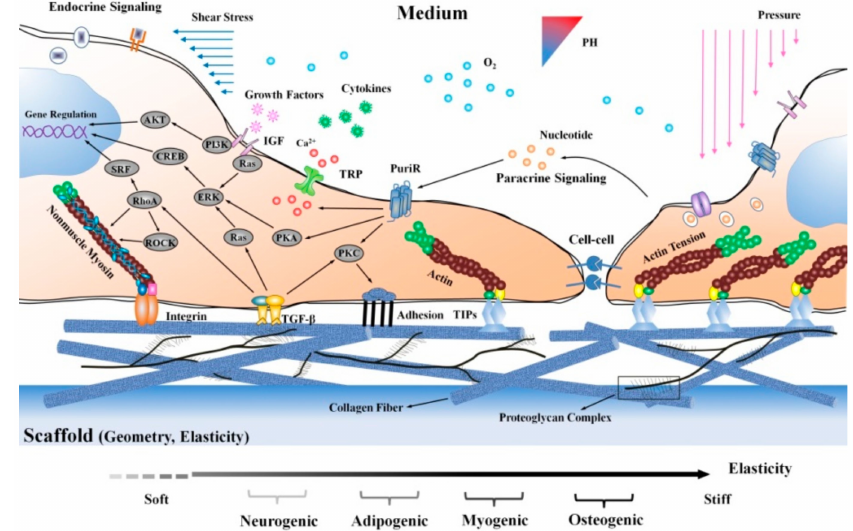
Figure 9. Stem cell and their natural microenvironment. Factors influencing the stem cell niche can be roughly categorized in three groups: physical and mechanical factors such as shear forces, elasticity and topography, cellular issues such as immune and nerve cells, nearby blood vessels and neighboring stem cells and soluble factors such as oxygen, glucose, hormones, growth factors or signaling molecules [13]. Copyright 2018 Springer